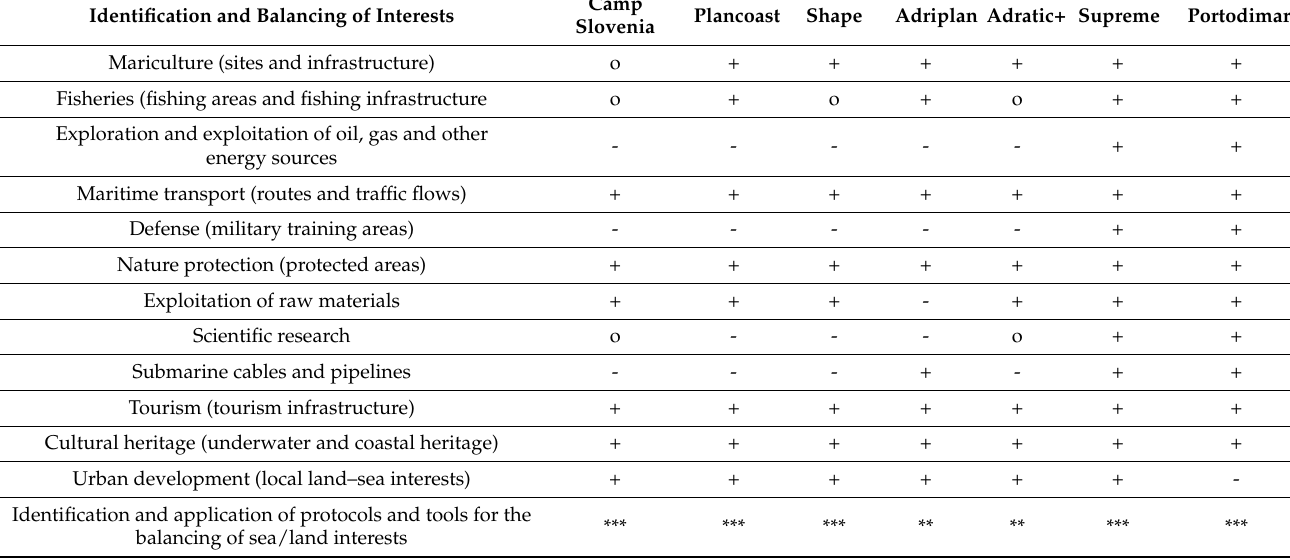
Table 8. Comparison of the draft plan and individual projects: identification and treatment of sectoral interests classified in 11 + 1 fields, as defined by the MSP